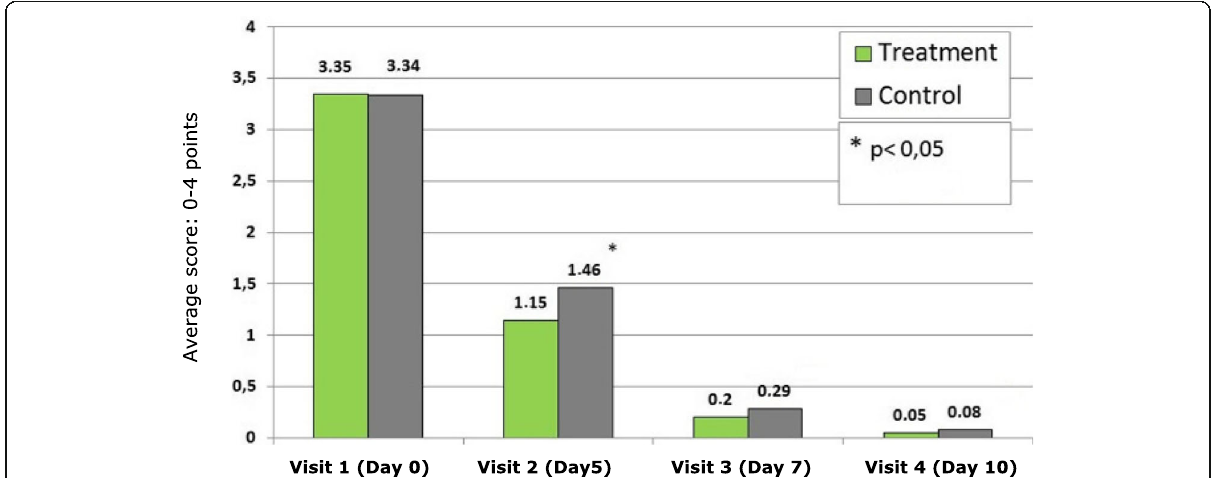
Fig. 2 Physicians ’ assessment of nasal discharge symptoms at visits 1 to 4. Average score (MSS scale: 0 – 4 points). * p < 0.05: Significant difference between